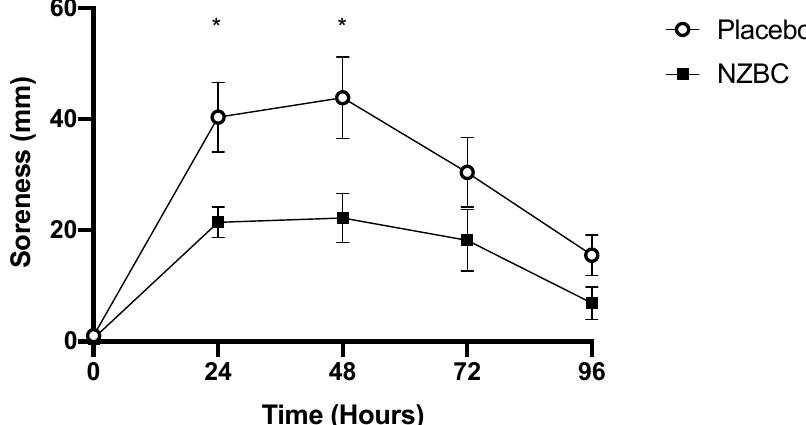
Figure 3. Muscle soreness before and after eccentric exercise in the PLA and NZBC groups. Values are means ± SEM, * significant difference between groups ( p < 0.05).